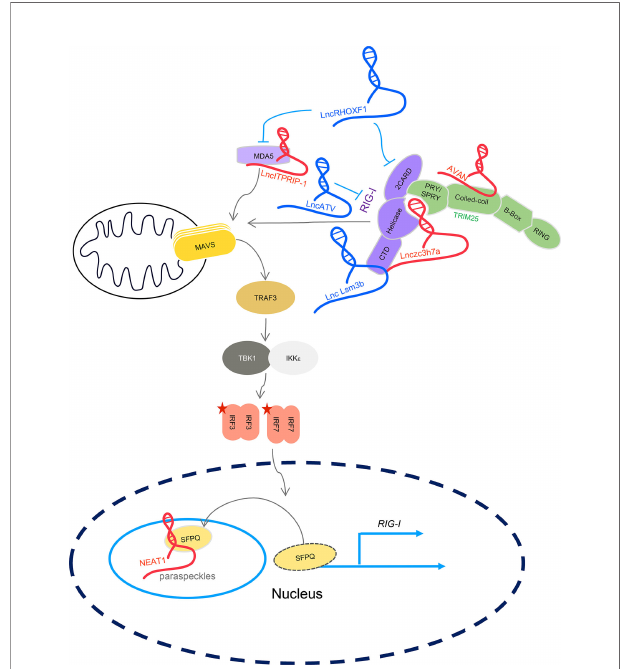
FIGURE 3 | LncRNAs regulates RLR-mediated IFN signaling. LncRNA NEAT1, lnczc3h7a, AVAN, and lncITPRIP-1 positively regulate IFN signaling through targeting proteins indicated in the fi gure. Lnc-Lsm3b, lncATV, and lncRHOXF1 negatively regulate IFN signaling by targeting RIG-I and RLRs. Five-sided star represents phosphorylation modi fi cation. LncRNA in blue represents negative regulators; lncRNA in red is positive regulators for IFN